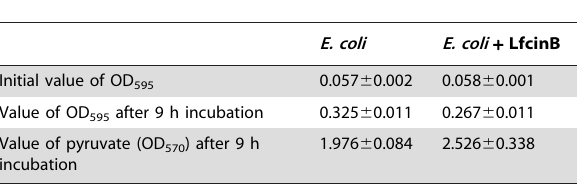
Table 2. Pyruvate assay